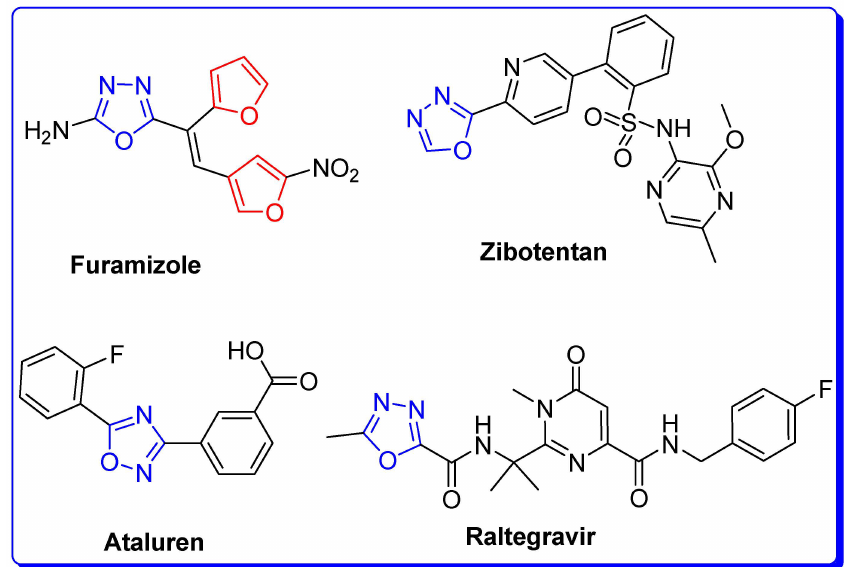
Figure 2. Clinical drugs with oxadiazole core.